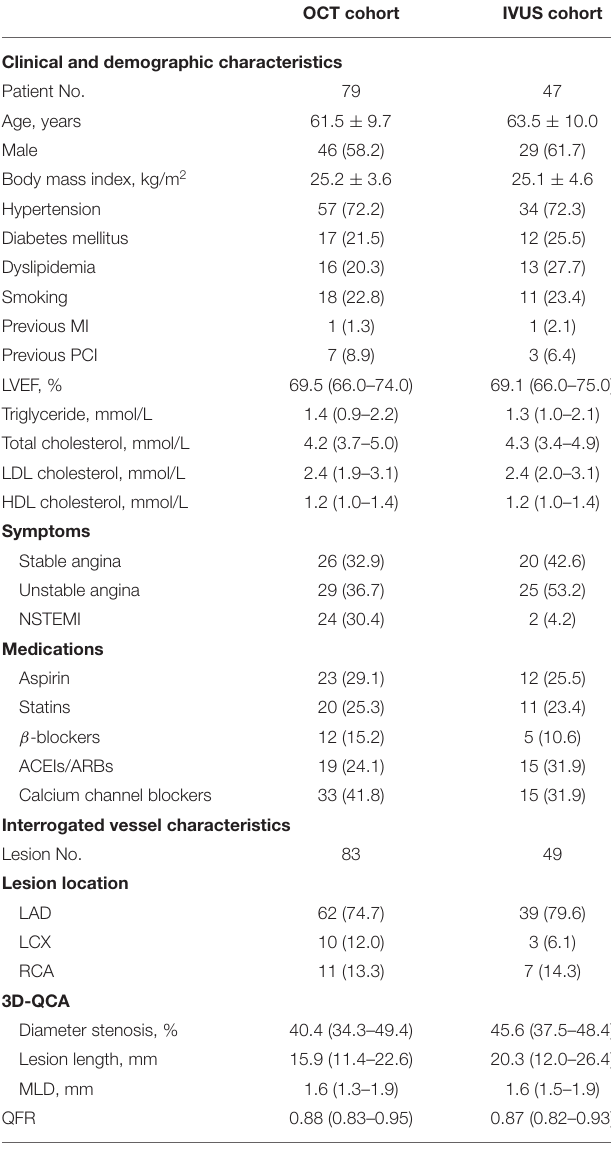
TABLE 1 | Baseline characteristics of included patients and